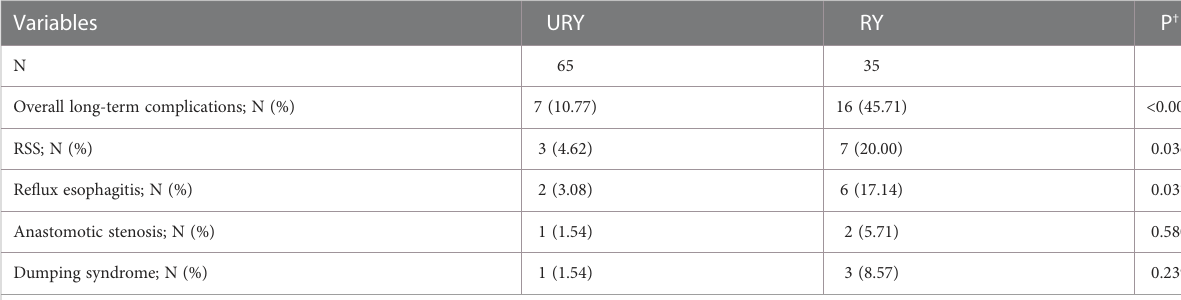
TABLE 3 Long-term postoperative